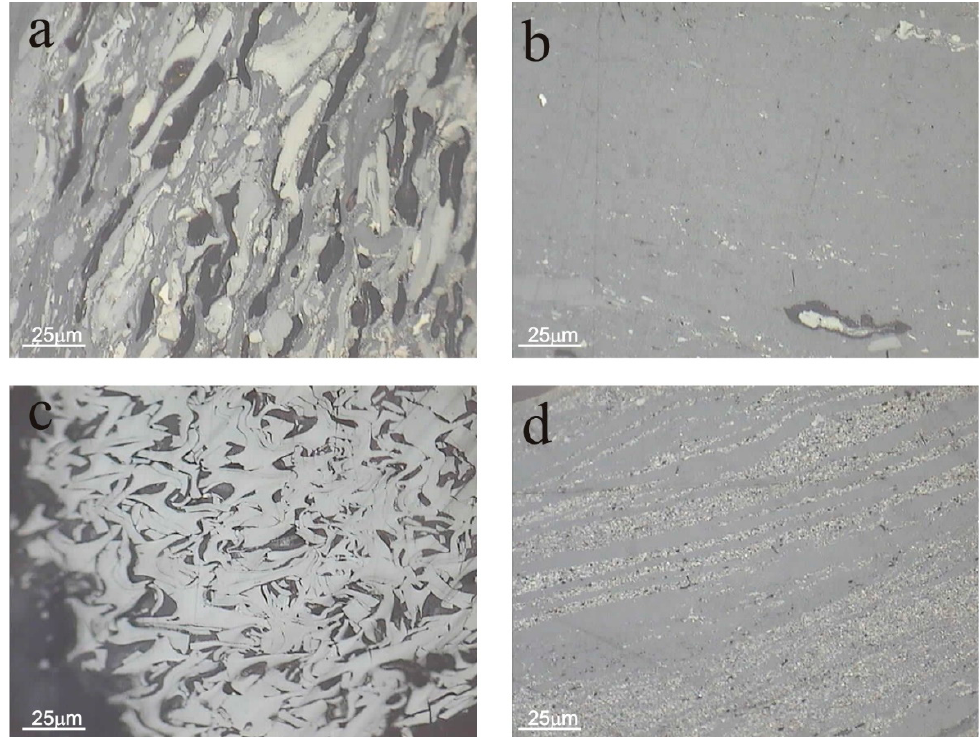
Figure 4. Raw sample of coal showing ( a ) trimacerite, ( b ) vitrinite–collotelinite, ( c ) inertinite–semifusinite, and ( d ) vitrinertite–collodetrinite and micrinite. Based on the results obtained, the raw coal sample was classified as low ash (A d < The content of macerals in the liptinite group was found to be 13% (Figure 3), with 10%), medium vitrinite (vitrinite content in mineral matter free state 40% < V mmf < 60%), the most frequently observed maceral in the liptinite group being sporinite in the form of macro- and microspores. Cutinite, resinite, and liptodetrinite were found in much smaller amounts (Figure